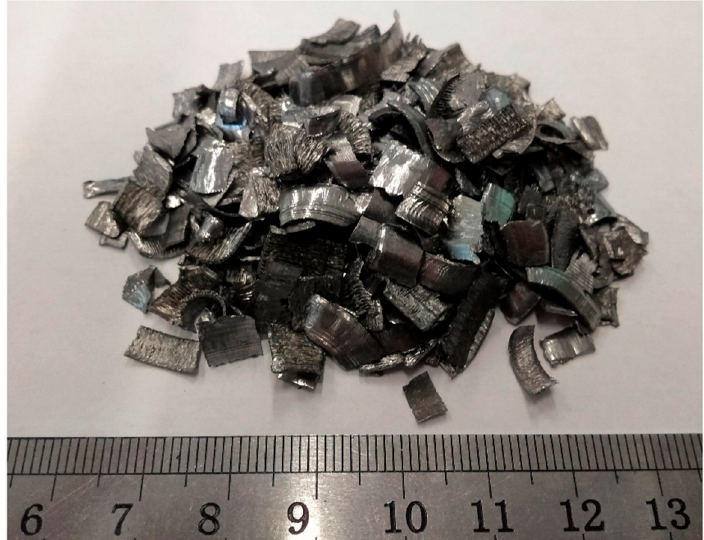
Figure 2. Photograph of the Ti-6Al-4V machining swarf feedstock (also referred to as scrap, turnings, or chips) procured for this study. The swarf has gone through a commercial grading and cleaning operation to remove contamination after the machining process.